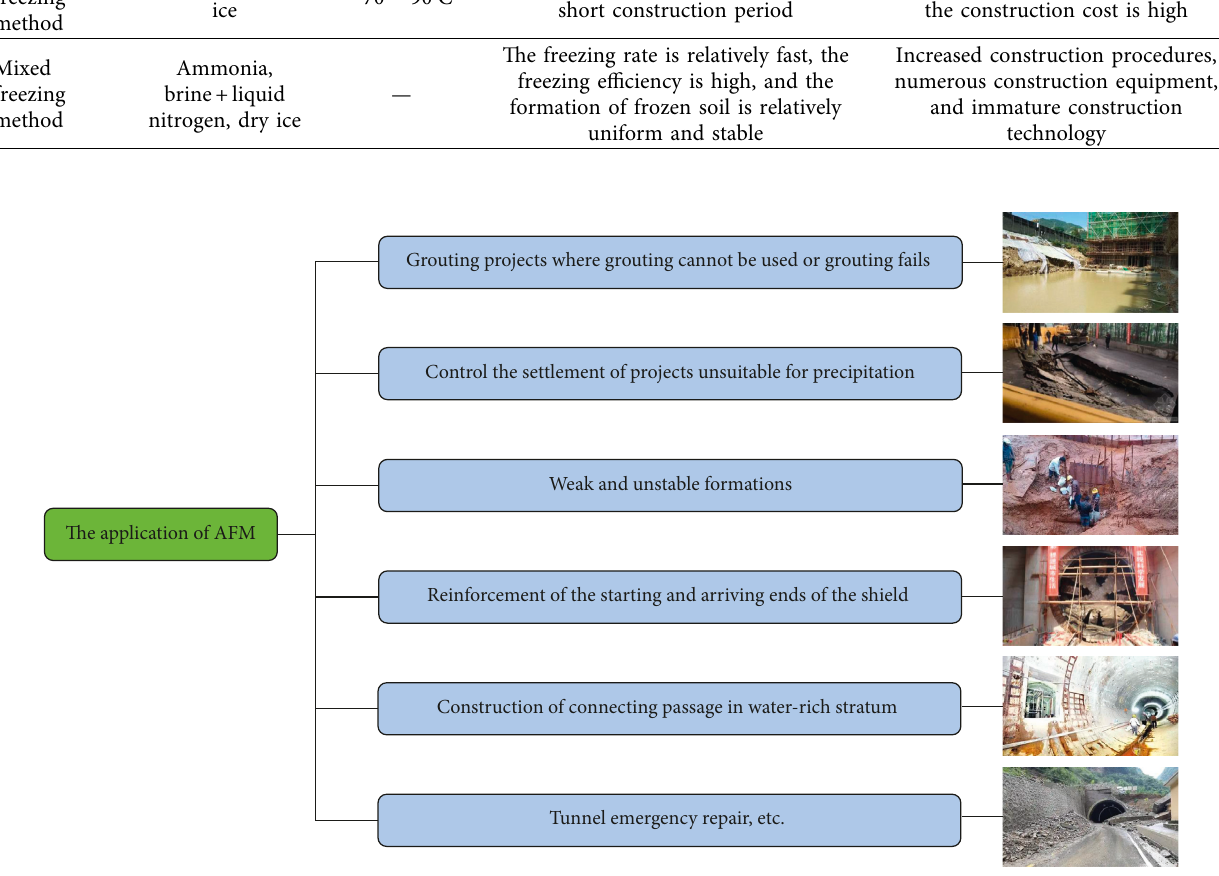
Figure 4: The scope and characteristics of the freezing method [51–53]. Table 2: Grouting reinforcement scheme of the project.